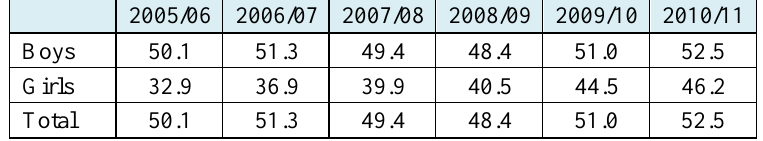
Table 4-9: Primary Completion Rate by Gender (Grade 8) (2005/06 - 2010/11)